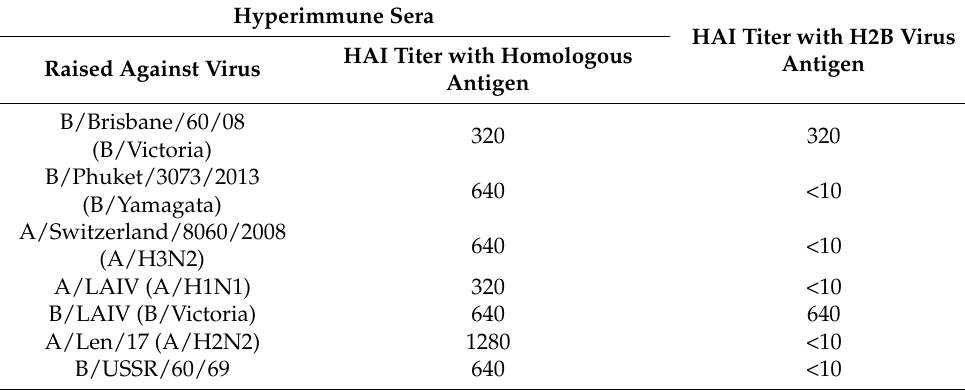
Table 3. Antigenic properties of the H2B chimeric virus. Hyperimmune Sera